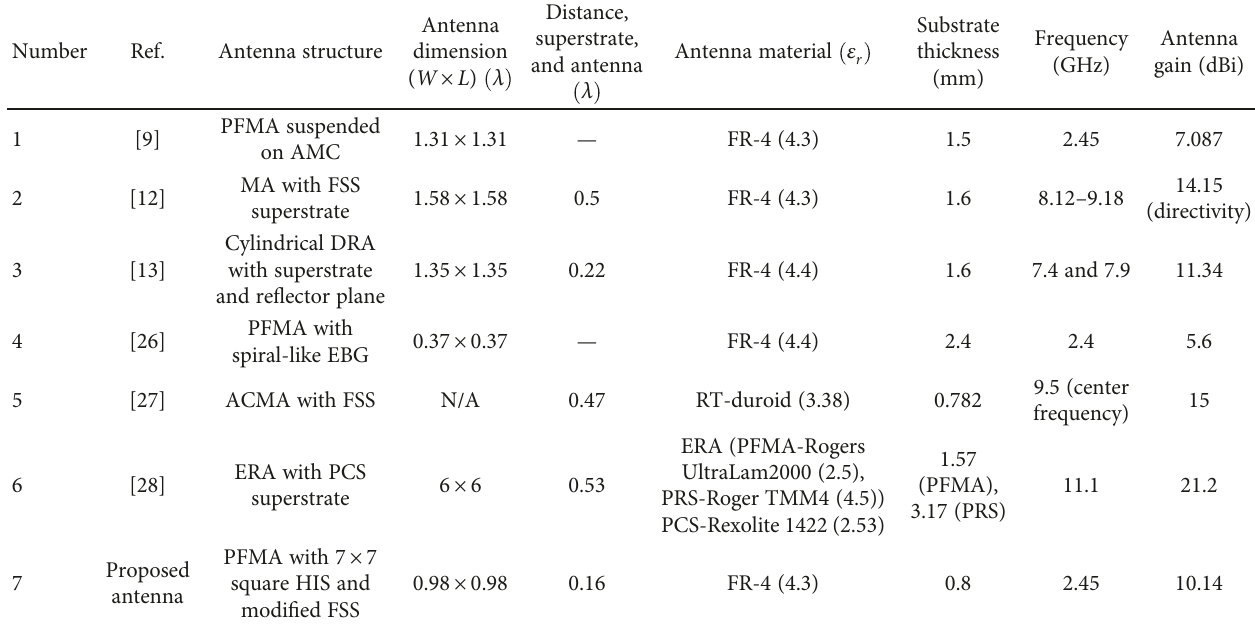
Table 2: The performance comparison of antennas with metamaterial(s).